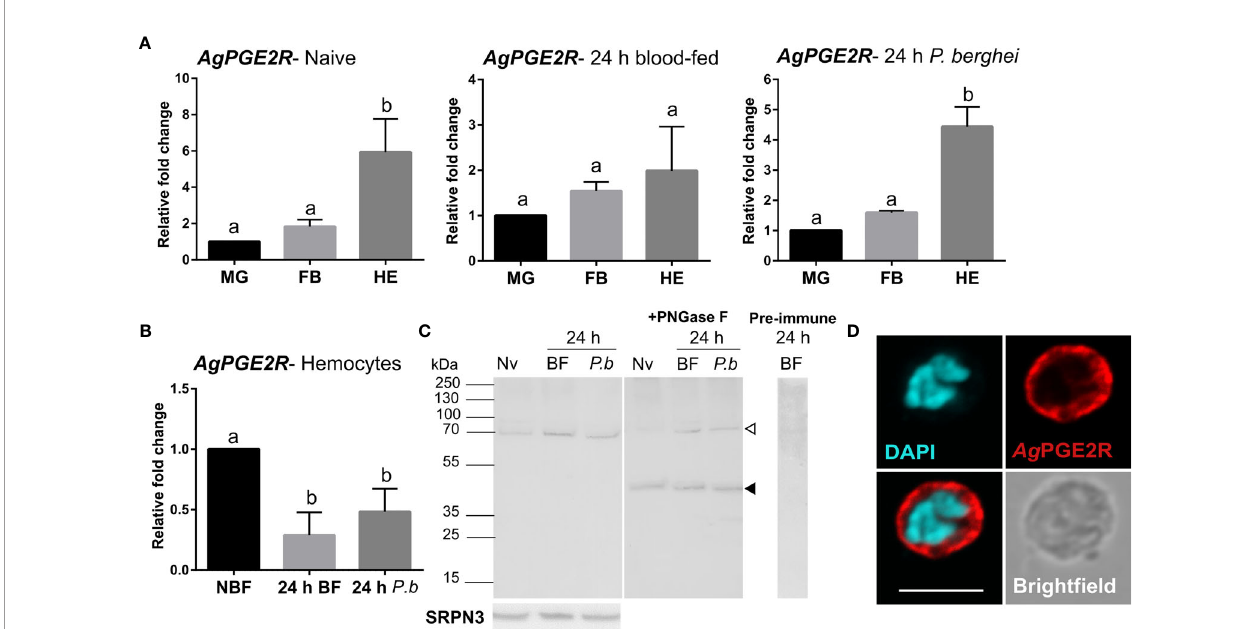
FIGURE 1 | Characterization of a prostaglandin E2 receptor (PGE2R) in Anopheles gambiae . (A) AgPGE2R gene expression was examined by qRT-PCR in midgut (MG), fat body (FB), and perfused hemocytes (HE) under naïve (NV), blood-fed (24 h BF), or P. berghei -infected (24 h P.b ) conditions. (B) AgPGE2R expression was more closely examined in hemocytes and compared across physiological conditions. For both (A, B) , letters indicate statistically signi fi cant differences ( P < 0.05) when analyzed by a one-way ANOVA followed by a Tukey ’ s multiple comparison test using GraphPad Prism 7.0. Bars represent the mean ± SE of either three or four independent biological replicates. (C) Perfused hemolymph from naïve (NV), blood-fed (BF), or P. berghei infected ( P.b ) mosquitoes were examined by Western blot analysis. Speci fi c bands were detected corresponding to a glycosylated Ag PGE2R product (bands at ~70 kDa, open arrowhead), or in which the receptor underwent deglycosylation with PNGase F treatment (~46 kDa, black arrowhead). The Ag PGE2R was detected using a rabbit antibody (1:1000) directed against intracellular loop 3 (ICL3). No bands were detected in a 24 h BF hemolymph sample incubated with pre-immune serum. Serpin 3 (SRPN3) was used as a protein loading control. (D) Immuno fl uorescence assays were performed on perfused hemocytes using a rabbit polyclonal antibody (1:500) against extracellular loop 2 (ECL2), revealing that PGE2R is localized to oenocytoid immune cell populations (scale bar, 5